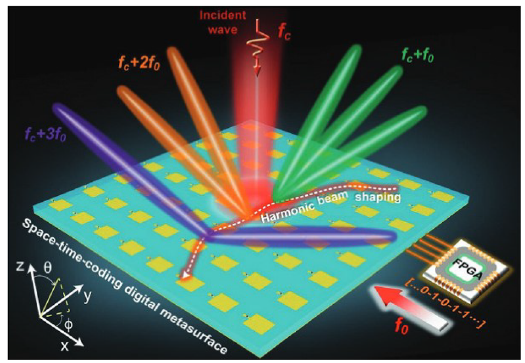
Table  : The advantages of metamaterials for